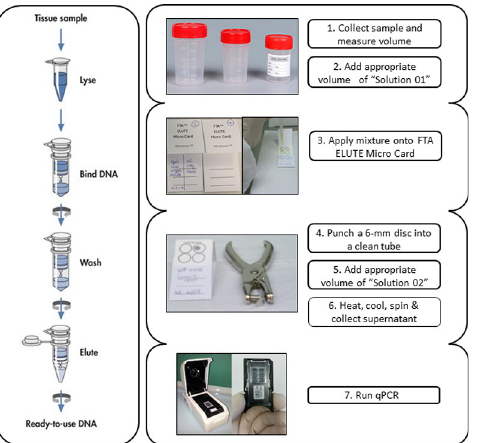
Fig 3. Comparative flowchart of the proposed simplified protocol. On the left panel, a general procedure for spin- column DNA extraction used in most commercial products. On the right panel, a step-by-step description of the simple and straightforward protocol for POC screening of tuberculosis-suspected